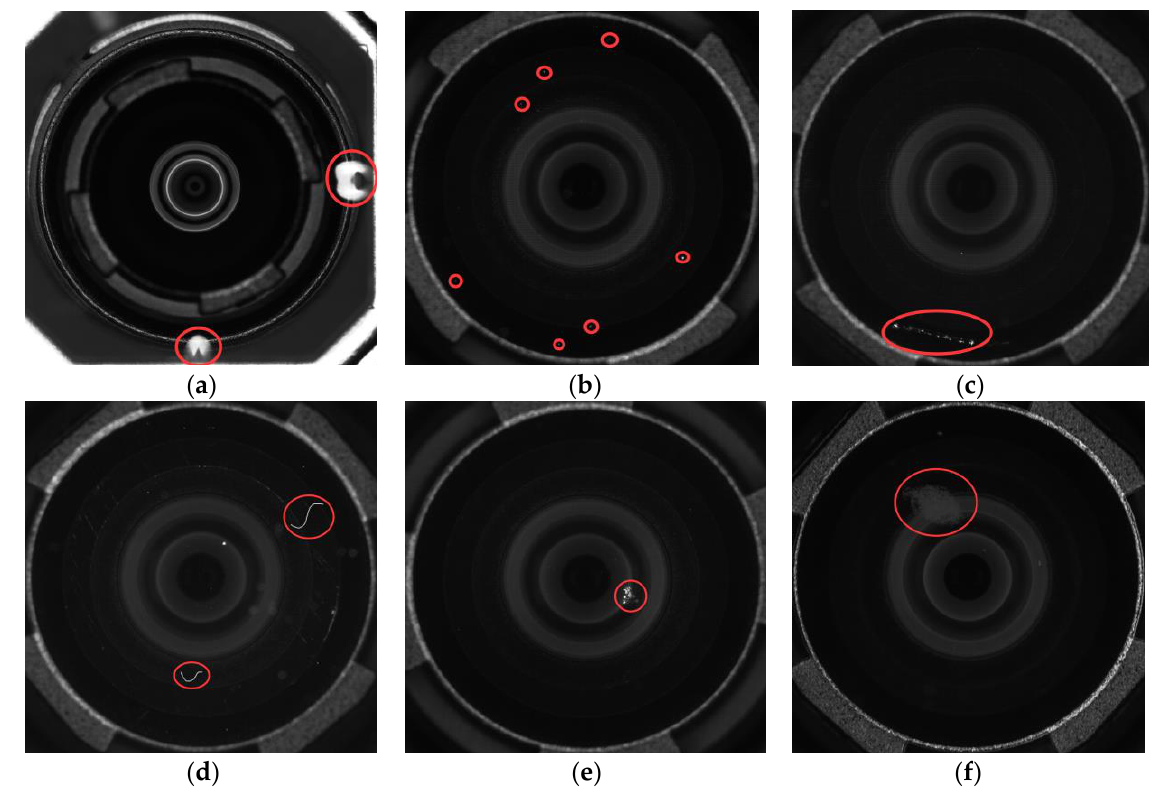
Figure 2. Camera module lens surface defect appearance. ( a ) White spots. ( b ) White dots. ( c ) Scratch. ( d ) Hair filaments. ( e ) Foreign objects. ( f ) Dirt.